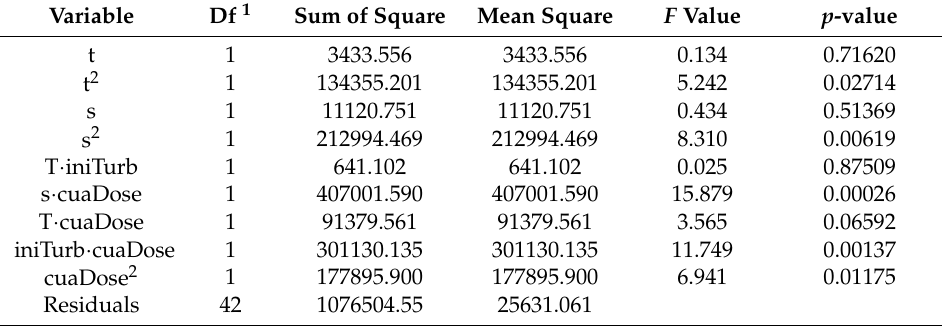
Table 8. ANOVA values for the “TSS” quadratic model for ECOTAN BIO 100.